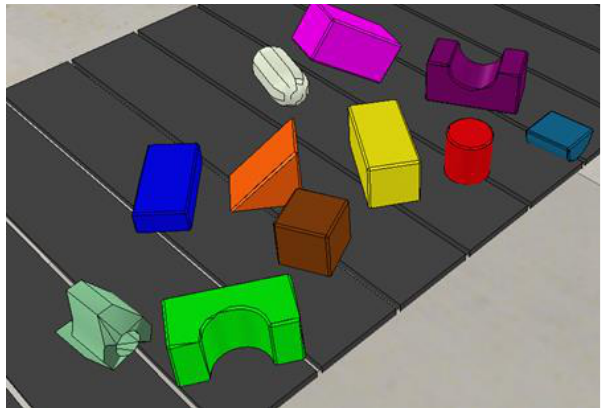
Figure 10. Ten regular and irregular 3D objects randomly used in the approach.